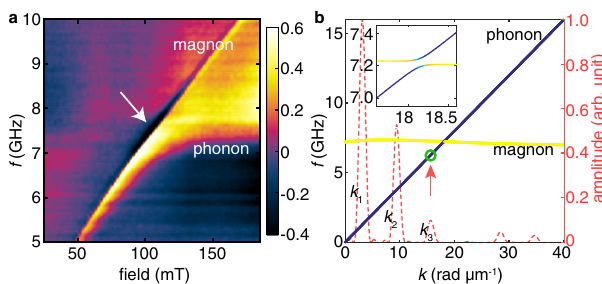
Fig. 3 The mode hybridization induced by magnon – phonon coupling. a Transmission amplitude S 21 measured on Sample Z15 as a function of magnetic fi eld applied in the direction of θ ¼ 54 (cid:3) . An anticrossing-like feature is observed between the magnon mode and the phonon mode. The fi eld-independent phonon mode is attributed to the high-order ( k 3 ) excitation from the CPW antenna. The white arrow marks the magnon – phonon hybridized mode (mode X) with strong intensity. The data displayed in the color map is the imaginary part of the transmission spectra, and the color bar denotes the amplitude of the imaginary part, which is in arbitrary units. The data are treated with a background subtraction of the reference spectrum at zero fi eld. b Simulation results on the hybridization of the magnon and phonon dispersions with a fi xed applied fi eld of 100 mT at θ ¼ 45 (cid:3) . The blue and yellow lines stand for the phonon and magnon branches, respectively. The zoom-in dispersion around the crossing point is shown in the inset where the green color suggests the magnon – phonon hybridization. The wavevector ( k ) excitation pro fi le (red dashed line) is calculated by Fourier transformation of the CPW antenna. The amplitude (scales on the right) is normalized to that of the k 1 excitation. The green circle (at k 3 excitation) indicates the hybridization off the crossing point that may lead to the anticrossing-like behavior in ( a (CPW) antennas 5,8,46 (e.g., Sample Z15), the excitation is known discrete peaks (red dashed line in Fig. 3b and Supplementary Fig. 2). In the fi eld-dependent transmission spectra measured on